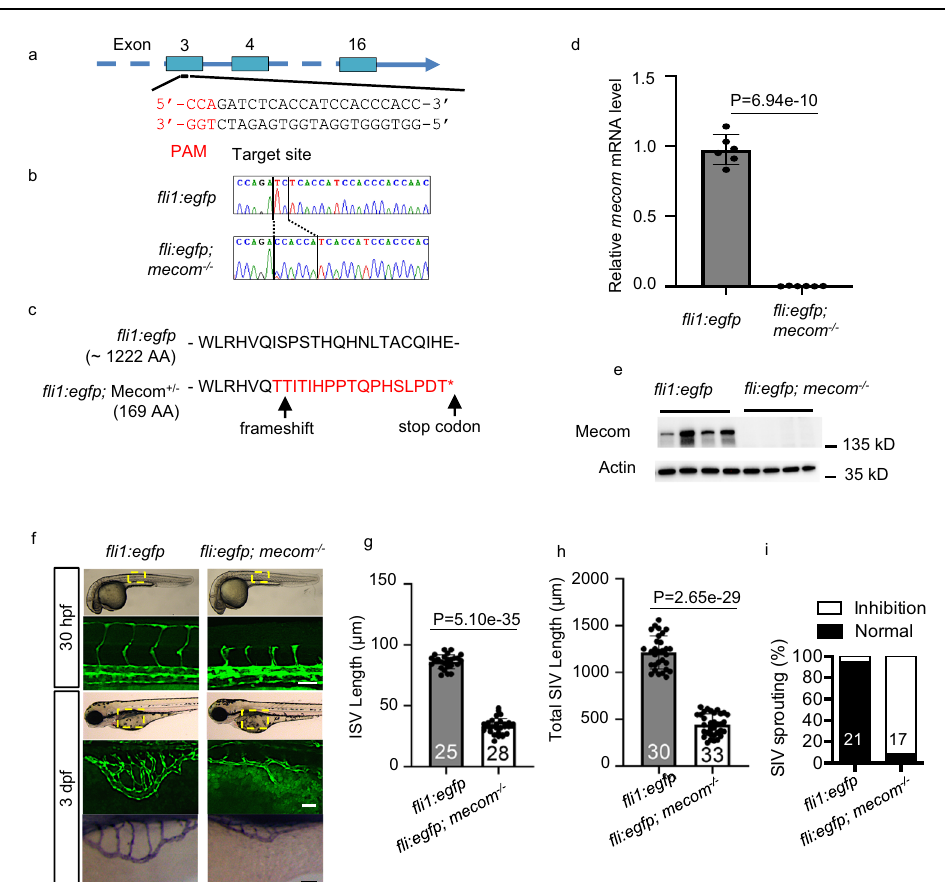
Fig.4|Depletionof mecom impairszebra fi shbloodvesselformation.a CRISPR- cas9 target site on mecom gene. The target sequence is based on the anti-sense strand. b DNAsequencingof mecom mutantanimals.ThePCRproductcoveringthe designed mutation site was cloned into T-vector and the individual colony har- bored the insert was sent for DNA sequencing. The TC → CCACCA indel causing frameshiftinmecomgeneishighlighted.Theverticalbarsdemarcatethemutation site. c mecom gene disruption produces a truncated protein. d Relative gene expression levels of mecom . e Western blot to show Mecom protein levels.